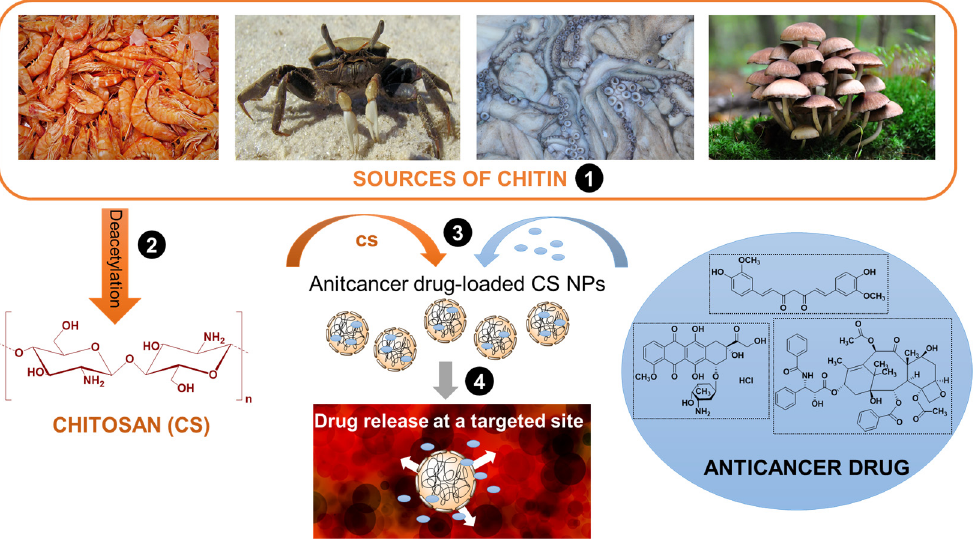
Figure 3. A schematic pathway from natural products to efficient delivery and release of anti-cancer drugs in targeted sites by chitosan-based nanoparticles.